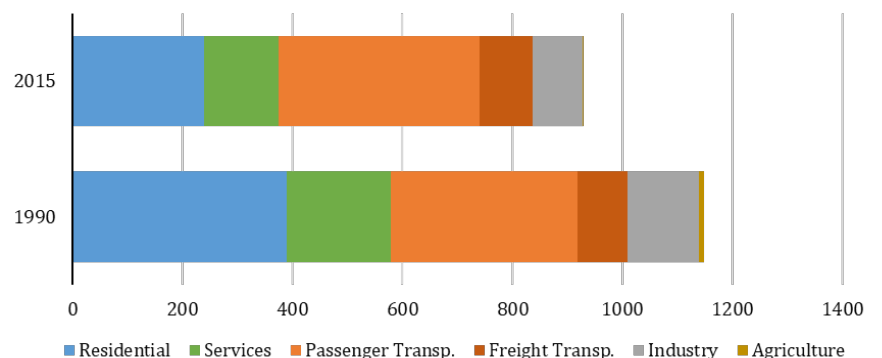
Figure 3. Change in annual GHG emissions per sector (ktonCO 2 eq. ) for the municipality of Malmö, between 1990 and 2015.